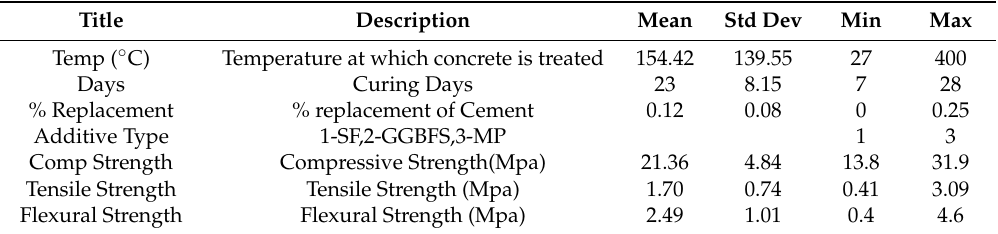
Table 7. Descriptive statistics of parameters for self compacted concrete.